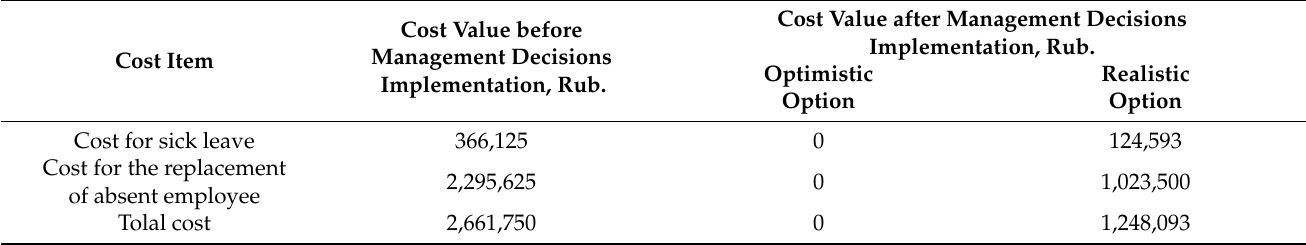
Table 9. Costs assessment before and after management decisions